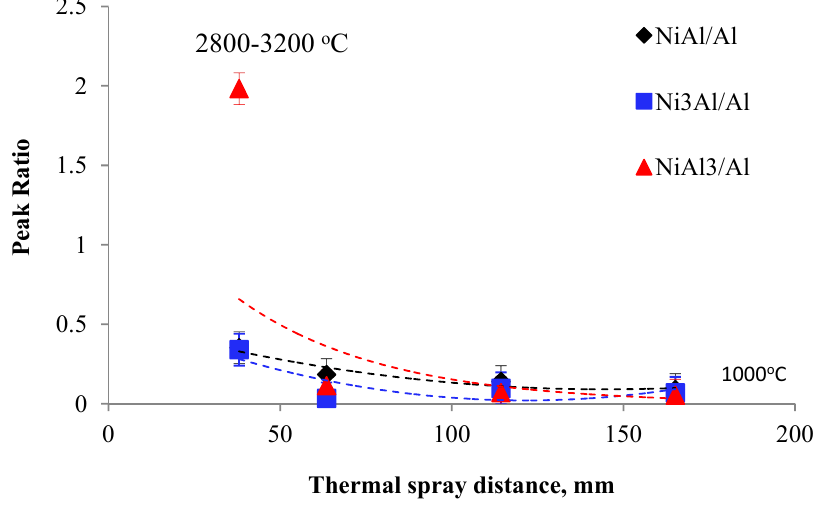
/C H on the final 2 2 2